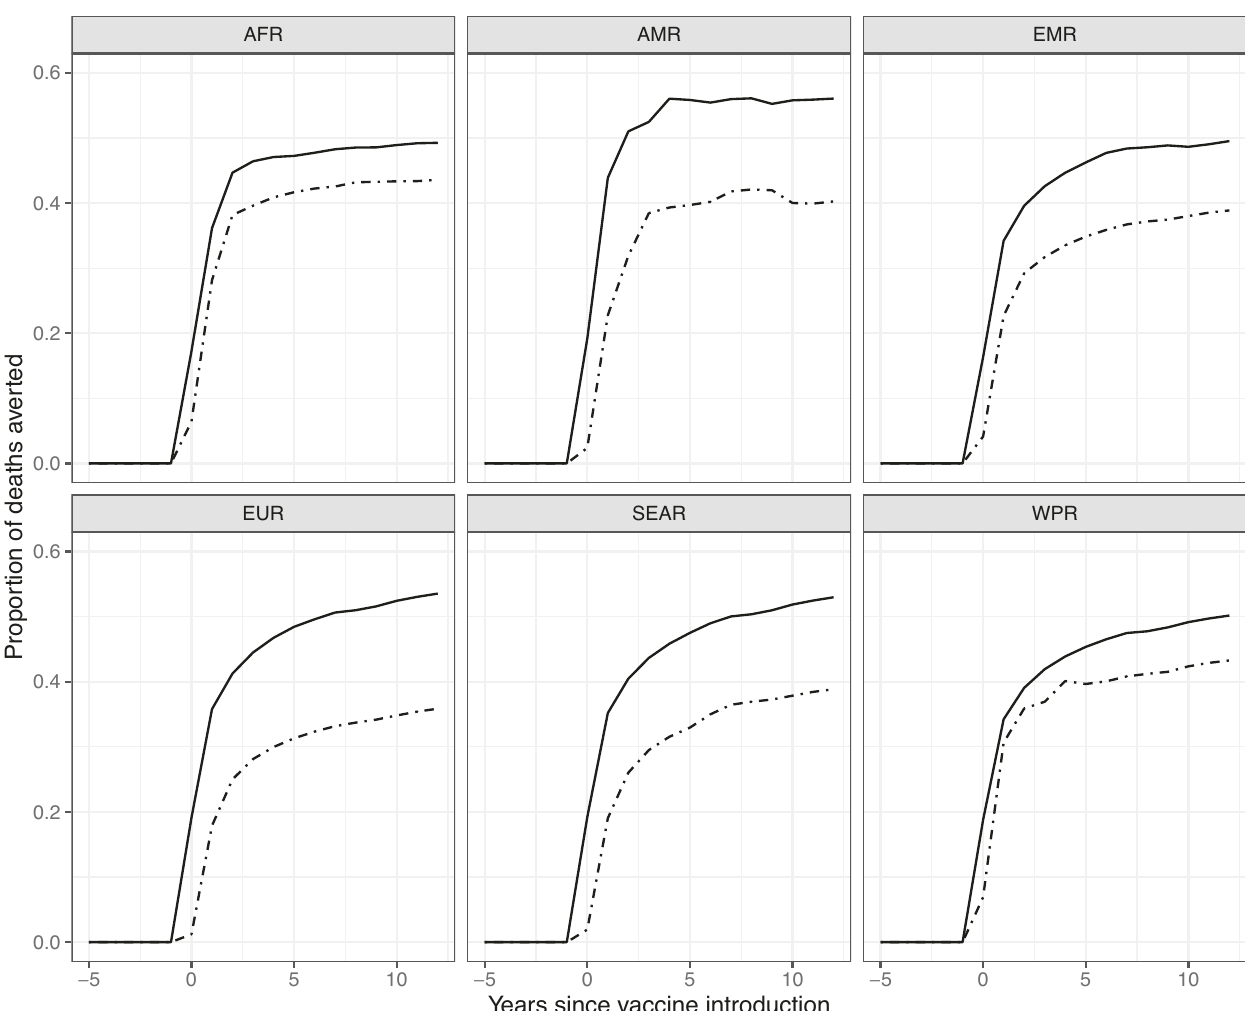
Fig. 1 Annual median direct and indirect effect by WHO geographic region. Annual median population direct effect (dashed line) and overall effect (solid line) up to 12 years post vaccine introduction by WHO geographic